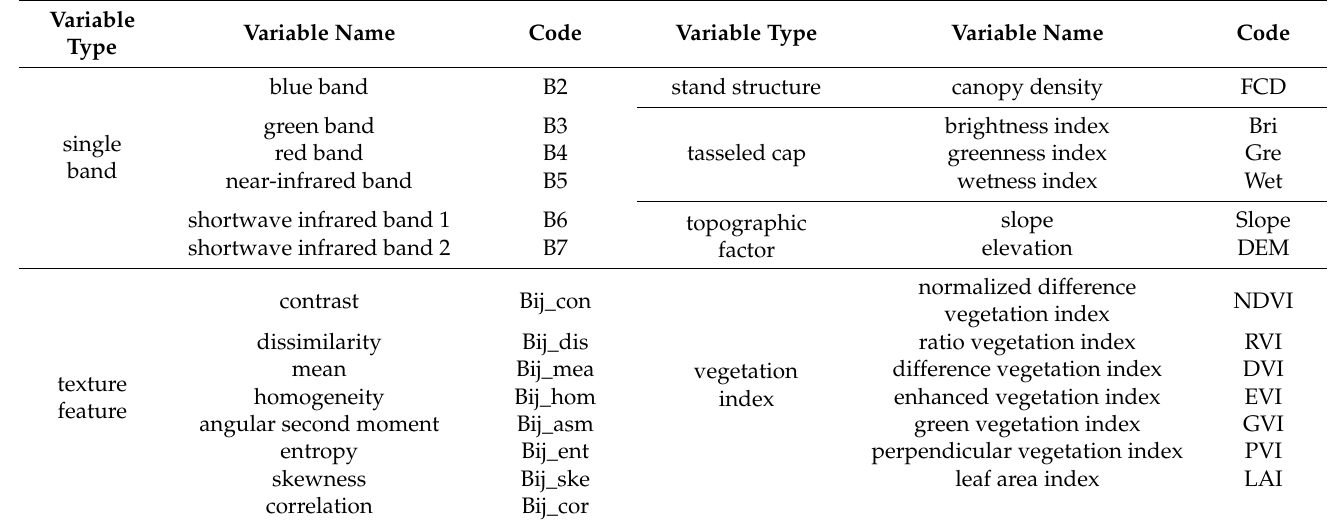
Table 3. Alternative independent variables of NPP remote sensing estimation